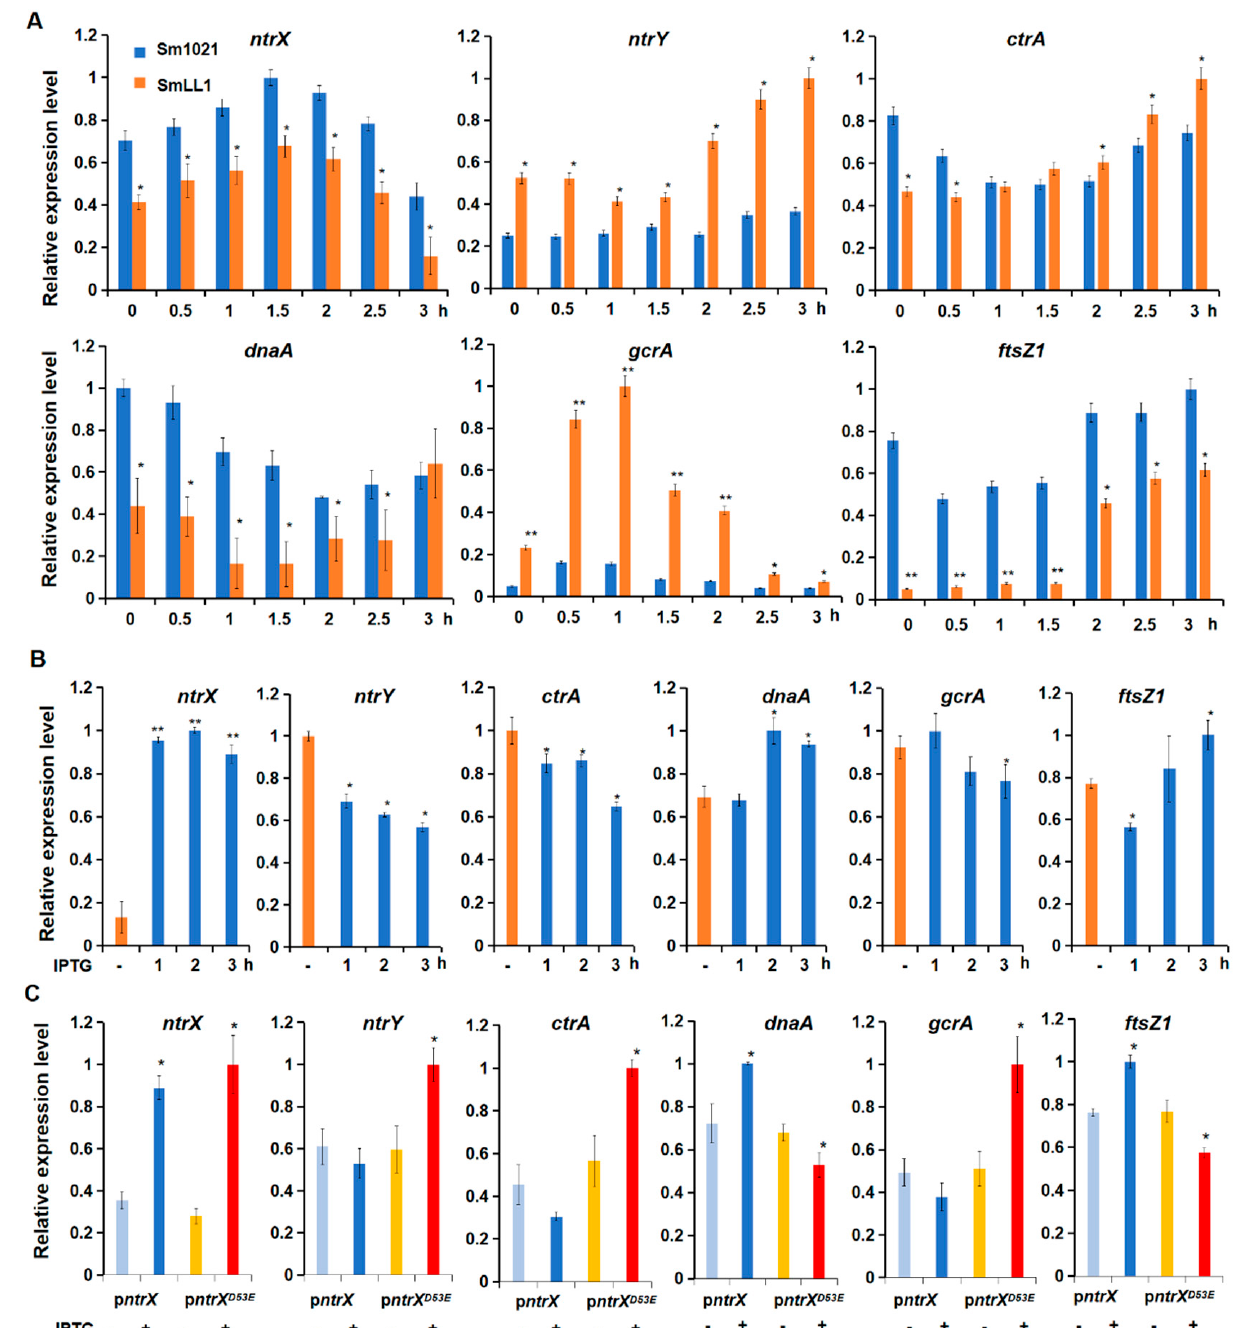
Figure 2. Differential expression of cell cycle regulatory genes in ntrX mutants evaluated by qRT- PCR. Synchronized cells of Sm1021 and SmLL1 were grown in LB/MC broth for half to three hours in ( A ). The depletion cells were grown in LB/MC broth with 1 mM IPTG for one to three hours, while the cells were incubated without IPTG for one hour as a control in ( B ). Synchronized cells of Sm1021/p ntrX and Sm1021/p ntrX D53E were grown in LB/MC broth with 1 mM IPTG for three hours in ( C ). Error bars, ± SD. The Student’s t -test was used for significance analysis. *, p < 0.05; **, p <